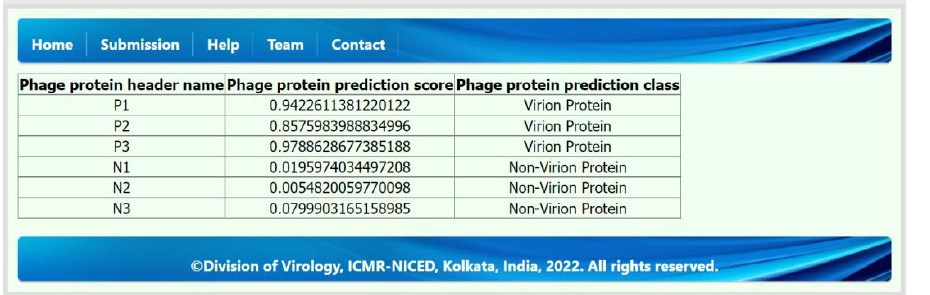
Figure 4. The result page of the web server shows a sample of example phage protein sequence prediction results in table format.